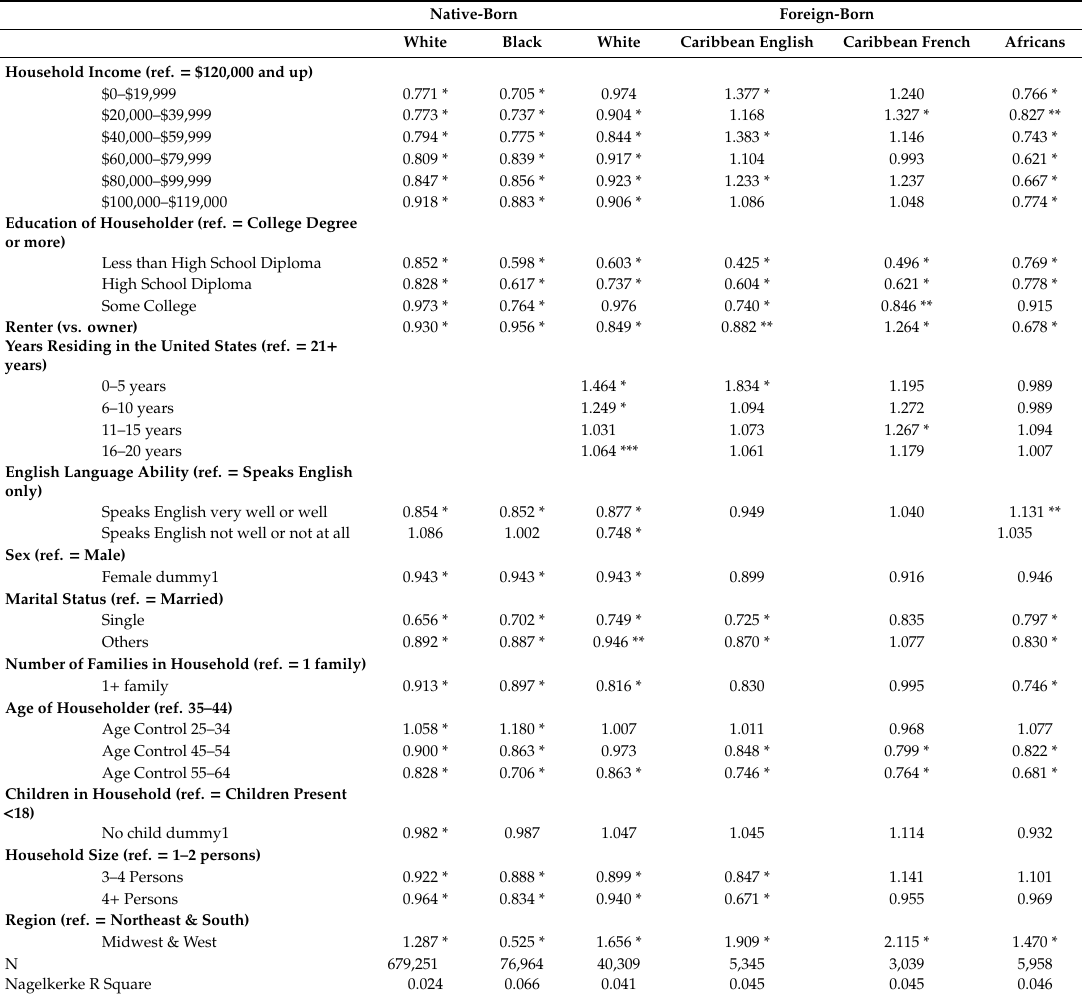
Table 4. Group Binary Logistic Regression Results Predicting Suburban Residence Type (vs. Mature Suburbs)—Odds